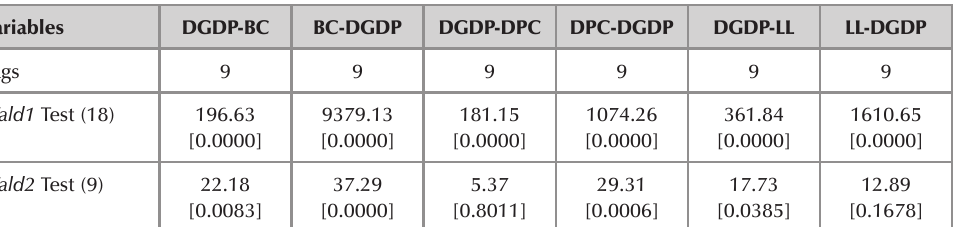
Panel GMM estimation for